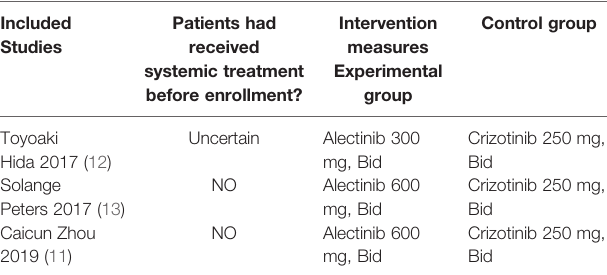
TABLE 3 | Basic characteristics of included studies.